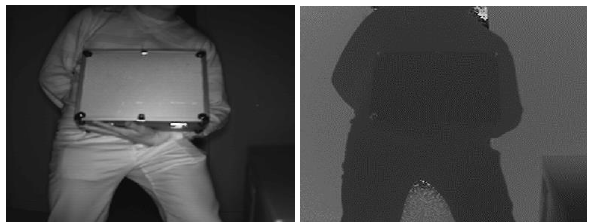
Figure 6. NIR intensity (left) and depth image (right) of the TOF camera. Depth values are similar for person and suitcase and noisy depth values can be seen around the